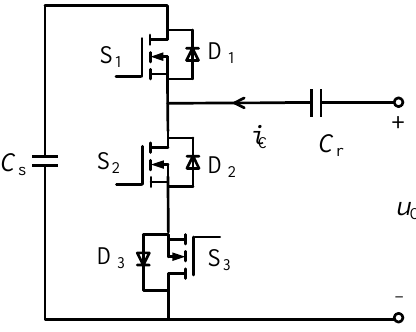
Figure 6. Scheme of an adjustable capacitor.